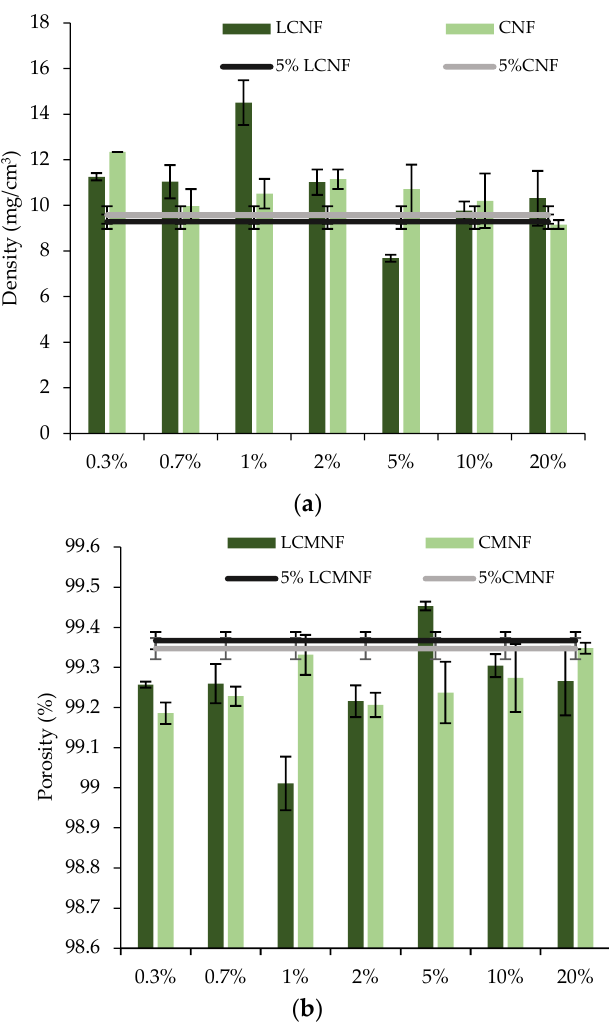
Figure 4. ( a ) Density and ( b ) porosity of bioactive aerogels. FTIR spectra of the bioactive aerogels (Figure S6) showed the same bands and peaks observed for the previous aerogels at low concentrations of BT (0.3–2%), indicating that no new functional groups are formed and that the retention of BT in the polymeric matrix could be purely a physical interaction. However, it is worth mentioning that, at high BT concentrations (5–20%), a new peak at 1730 cm − 1 is observed in both LCMNF and CMNF aerogels, which is due to the presence of lipid compounds from the extract [3]. This peak probably does not appear in the spectra of low BT concentration bioactive aerogels because the amount incorporated is too low to be detected. Peaks at 1592 cm − 1 , 1412 cm − 1